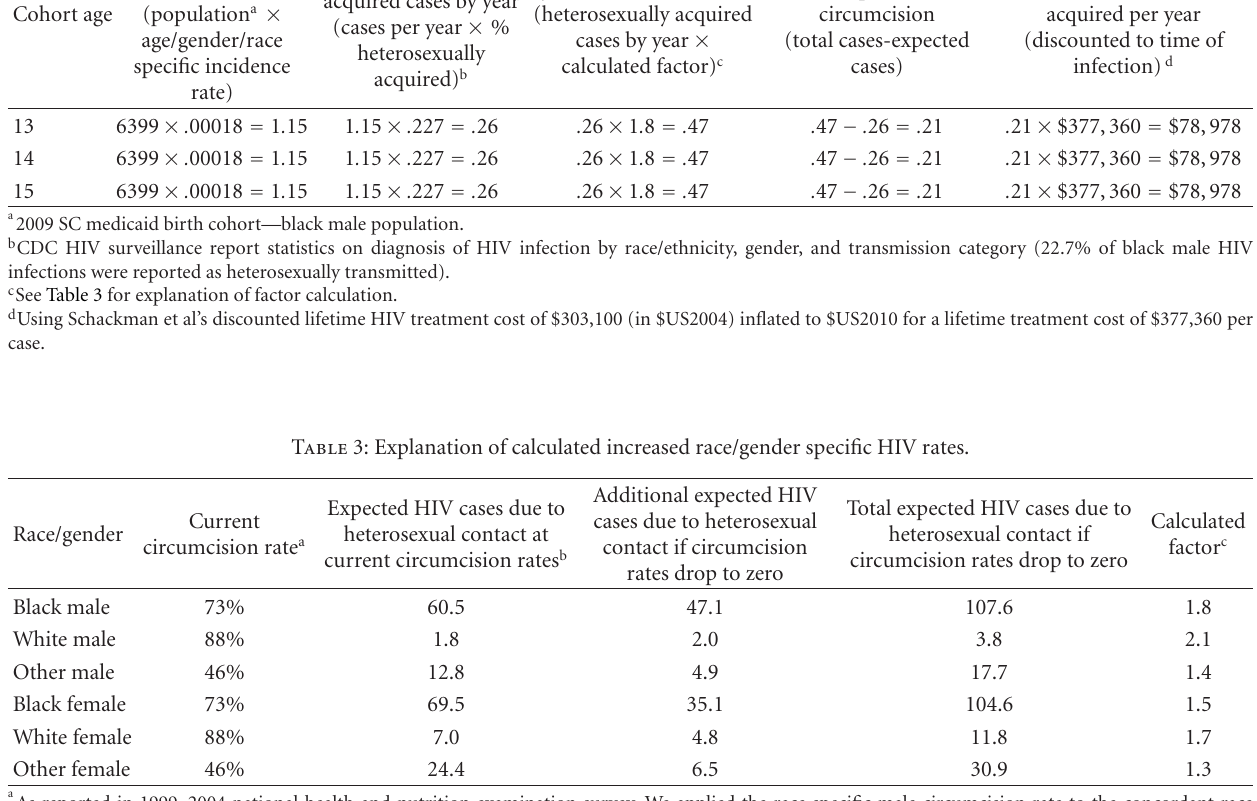
Table 2: Example calculation of black male expected heterosexually acquired HIV cases and cost; SC 2009 Medicaid birth cohort.